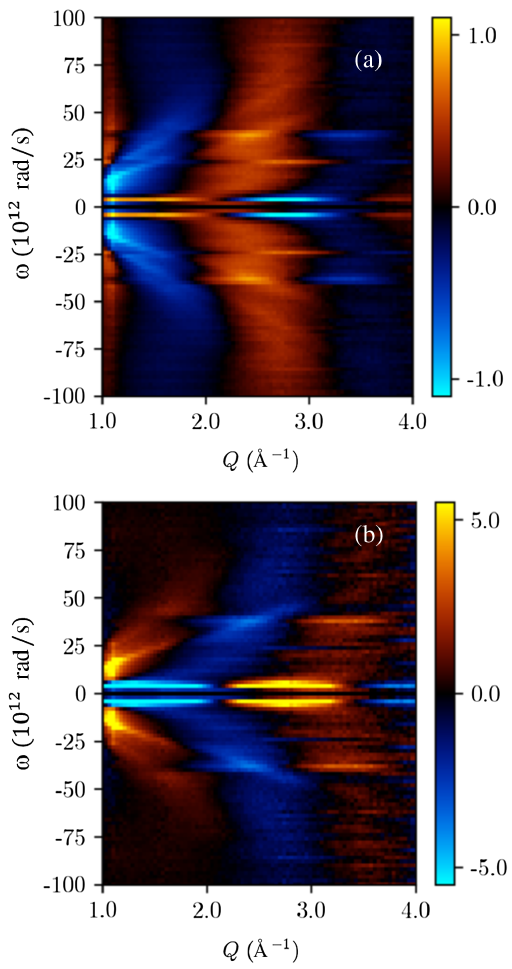
FIG. 6. Fourier transform of S 0 ð Q; τ Þ in Fig. 5 to form ˜ S 0 ð Q; ω Þg and (b) Im f (a) Re f